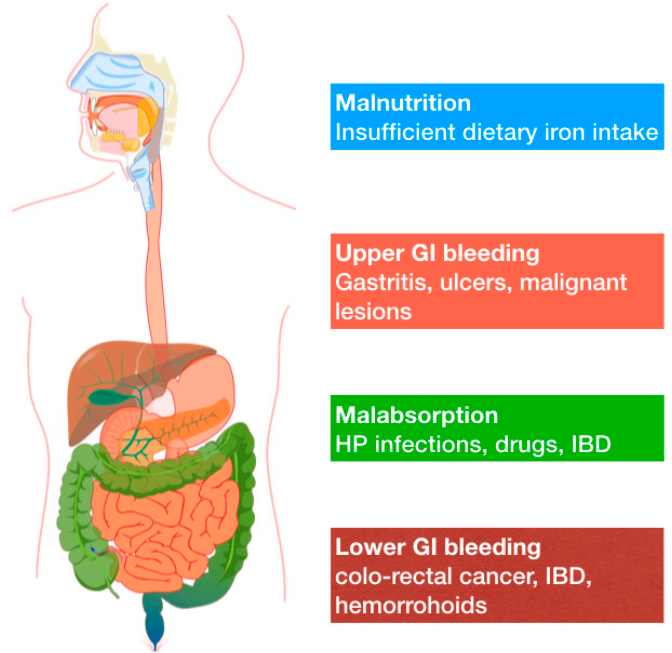
Figure 1. Common causes of IDA in adults include a broader range of potential mechanisms that are here synthetically depicted.